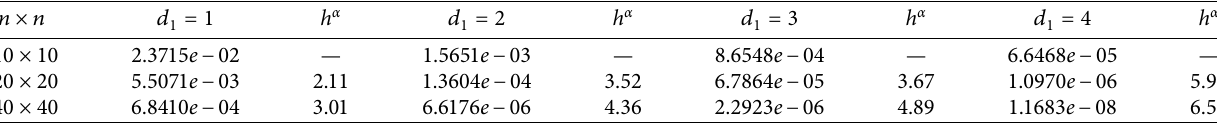
� 9 for Example 3. 2